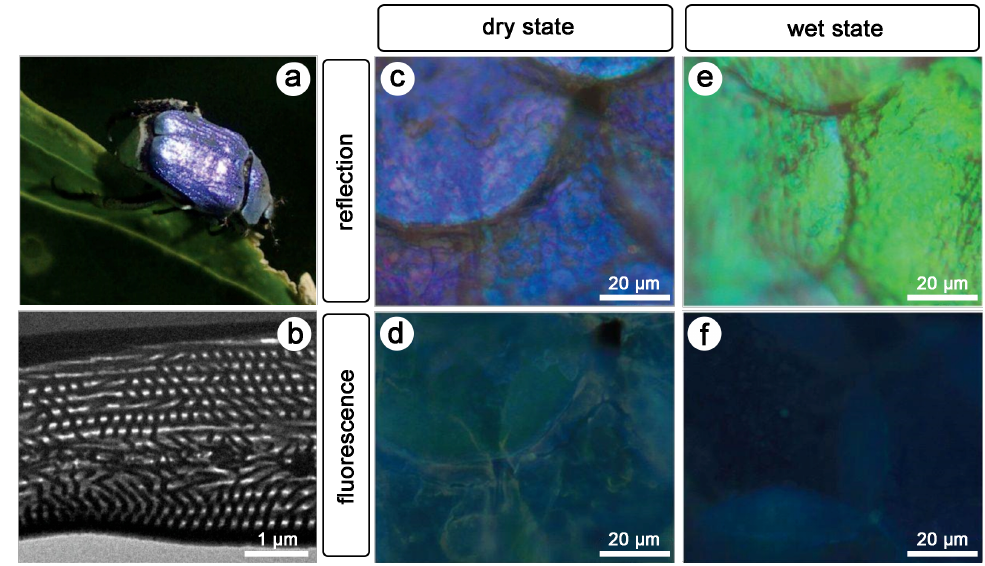
Figure 3. The blue-violet colour of the male beetle Hoplia coerulea ( a ) originates from a multilayer photonic structure. This porous periodic multilayer ( b ) occurs in the scales covering the elytra ( c ) and body of the insect. Upon UV light illumination, the scales display a turquoise colour through fluorescence ( d ). When in contact with water, the scales turn to green ( e ) and navy blue ( f ) under visible and UV lightillumination, respectively. Reproduced from Mouchet, S.R., Lobet, M., Kolaric,